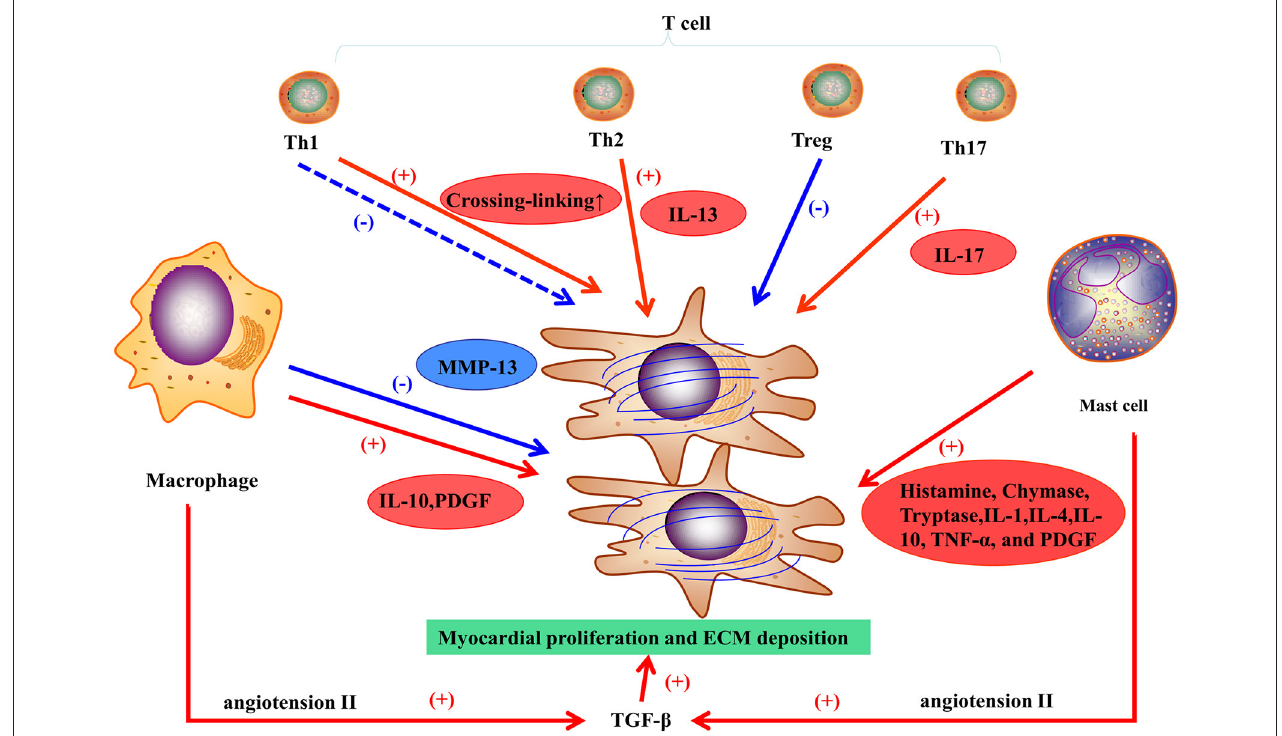
FIGURE 2 | Inflammatory response in myocardial